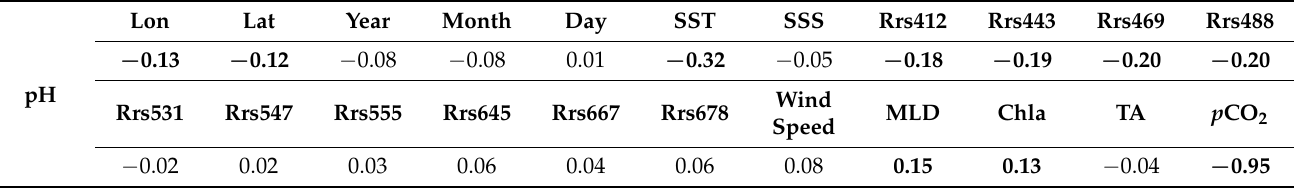
Table 3. The R-values of the pH-related